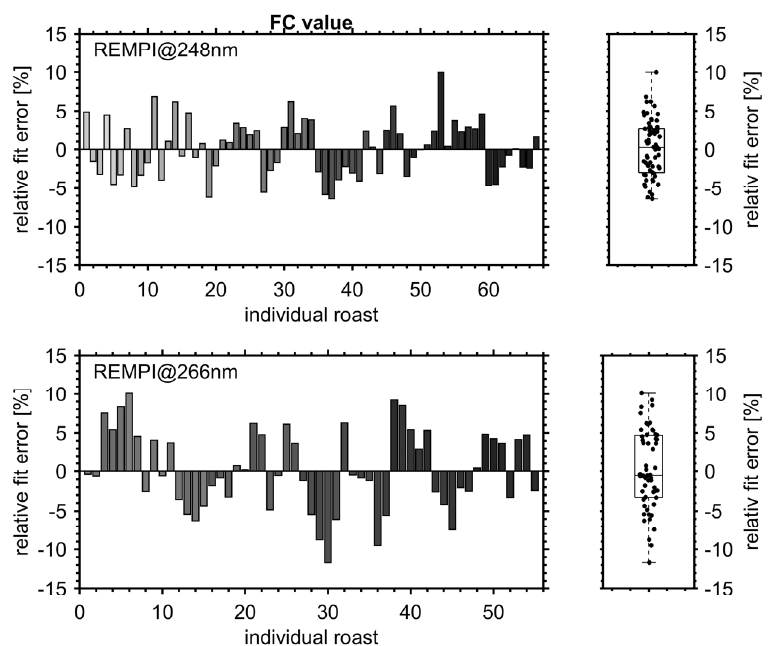
Figure A4. Relative fit error of individual roasts included in the calibration of the FC value prediction models ( left ) and its summary in a boxplot ( right ) showing minimum, maximum, 1st, 2nd (median), and 3rd quartiles.